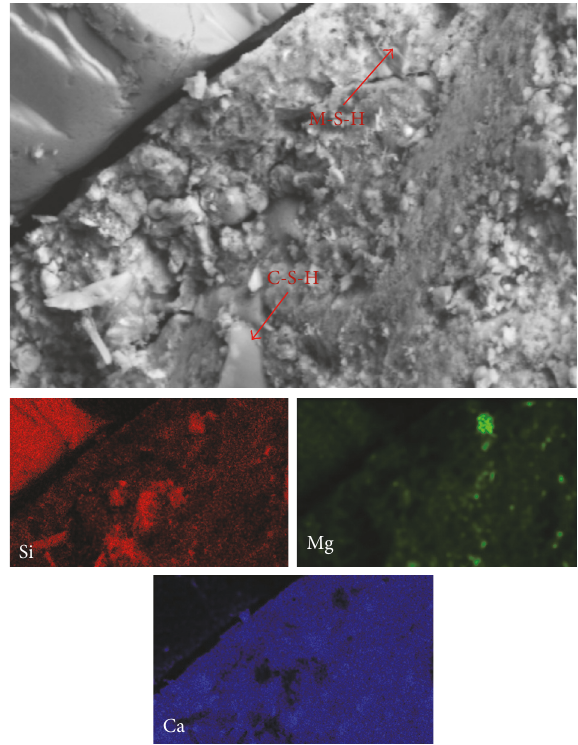
Figure 9: SEM image and its EDAX mapping on Si, Mg, and Ca of